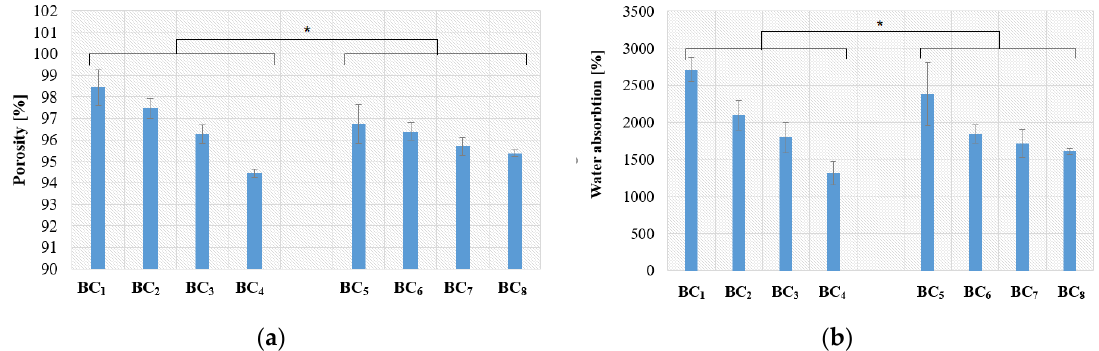
Figure 10. Porosity ( a ) and water absorption ( b ) results for the obtained composites (presented as mean ± S.D. of three replicates and * p < 0.005 obtained by single-factor ANOVA test.